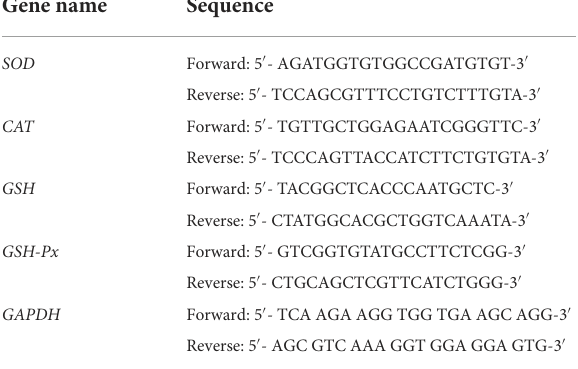
TABLE 1 The sequences of reverse transcription-polymerase chain reaction primers in this